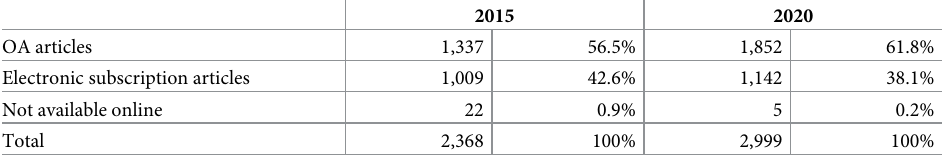
Table 2. Proportion of open access (OA) categories.